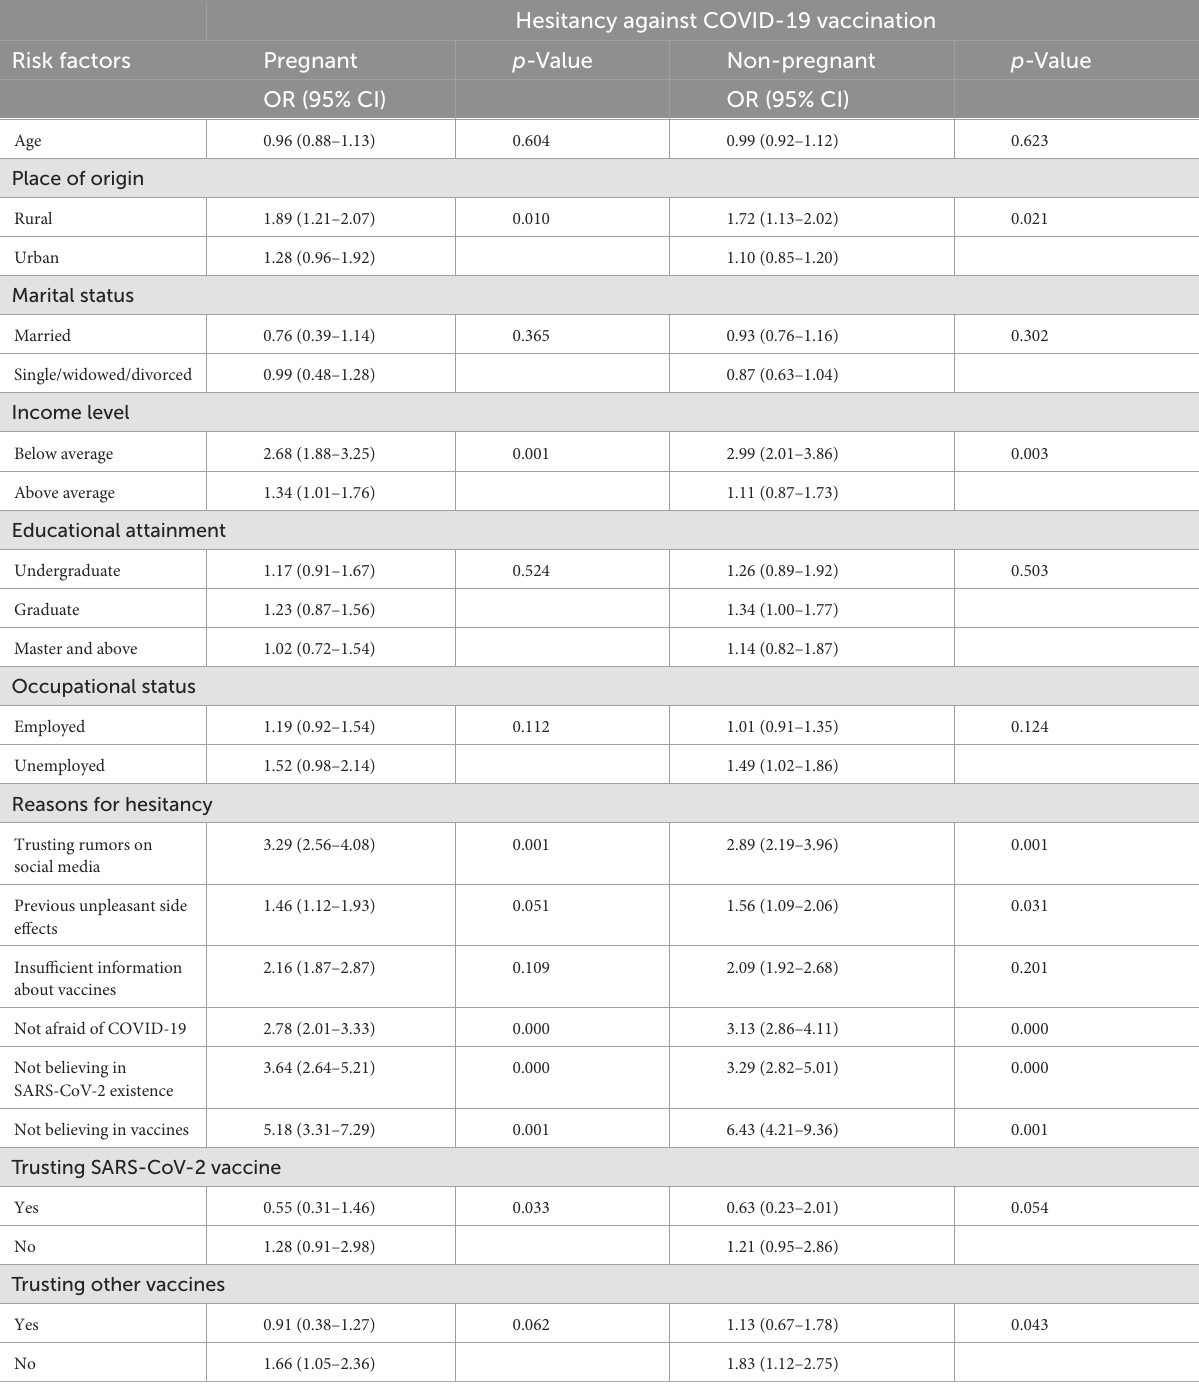
TABLE 4 Risk factor analysis of pregnant women against COVID-19